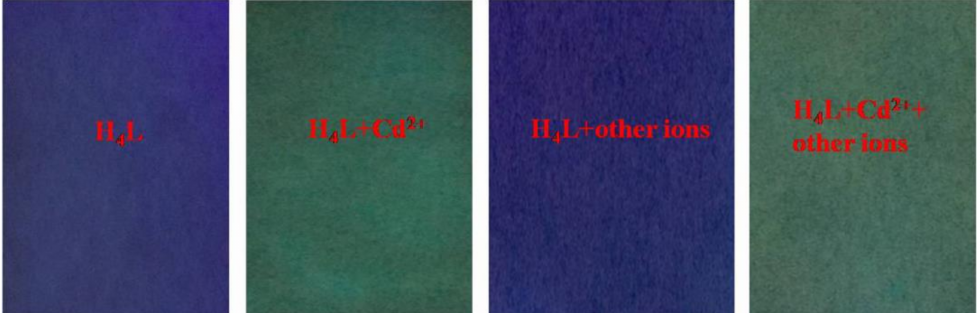
Figure 10. The result of colorimetric measured photographs with sensor H 4 L for detecting Cd 2+ under irradiation at 365